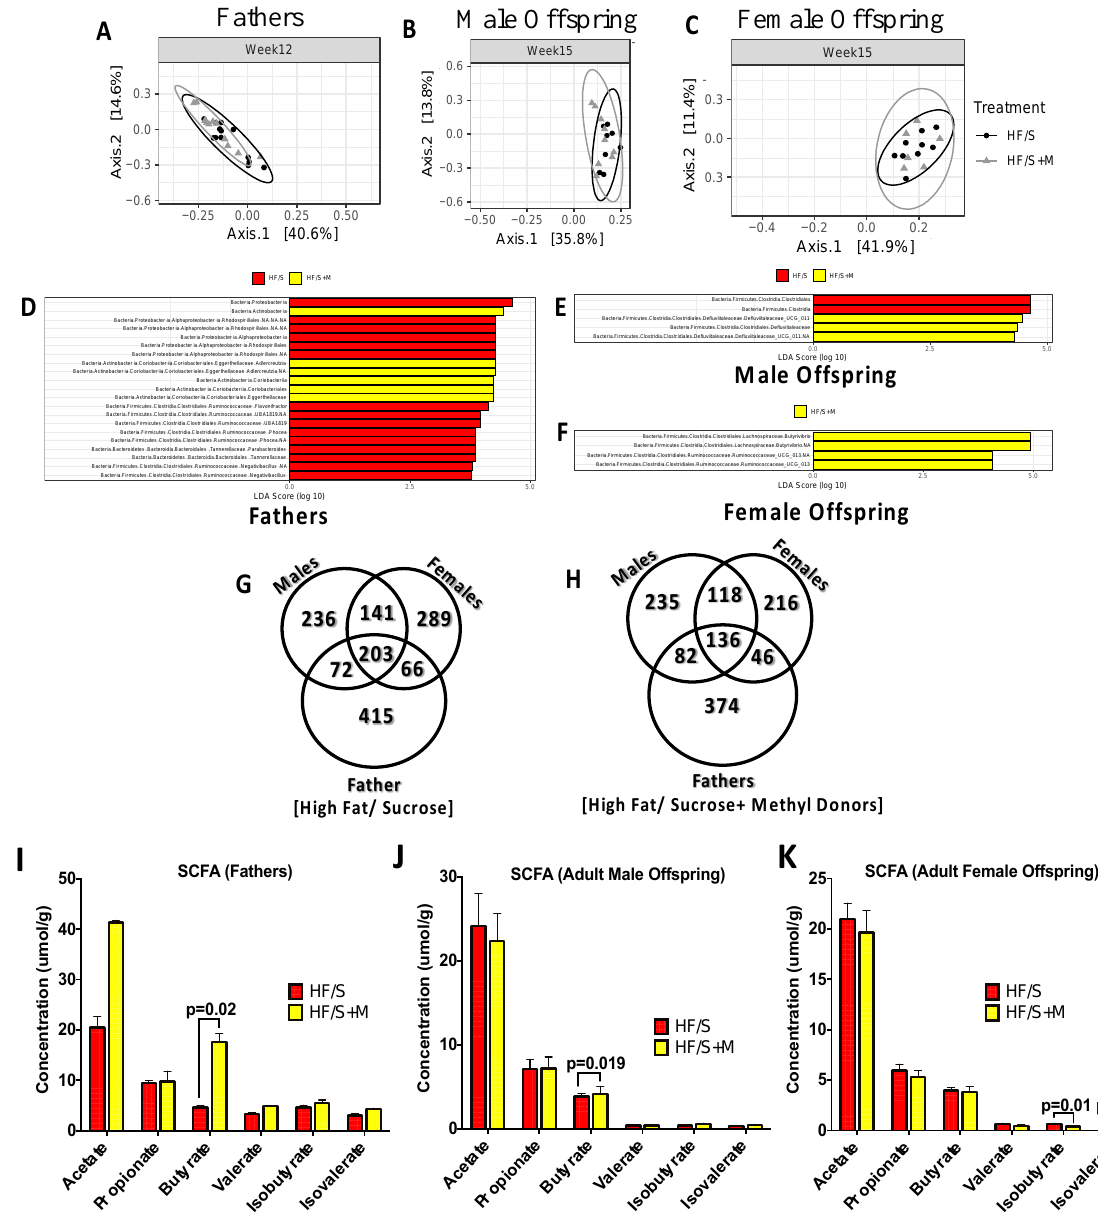
Figure 4. Fecal microbiota comparisons of fathers fed HF/S and HF/S+M and the intergenerational similarities in male and female offspring. Beta Diversity of ( A ) paternal at 12 weeks of age, ( B ) male offspring and ( C ) female offspring at 15 weeks of age, assessed with principal coordinates analysis (PCoA) using a Bray – Curtis distance matrix. Linear discriminant analysis effect size (LefSe) comparison of ( D ) Fathers at 12 weeks of age, ( E ) Male offspring and ( F ) Female offspring at 15 weeks of age. A Venn diagram comparison of ASVs that overlap between fathers and offspring and those only present in offspring, stratified by sex and ( G ) HF/S diet ( H ) HF/S+M diet. Cecal Short Chain Fatty Acids in: ( I ) paternal, ( J ) adult male offspring and ( K ) adult female offspring at euthanasia. Values are means ± SEM, n = 8–13 ( p < 0.05).